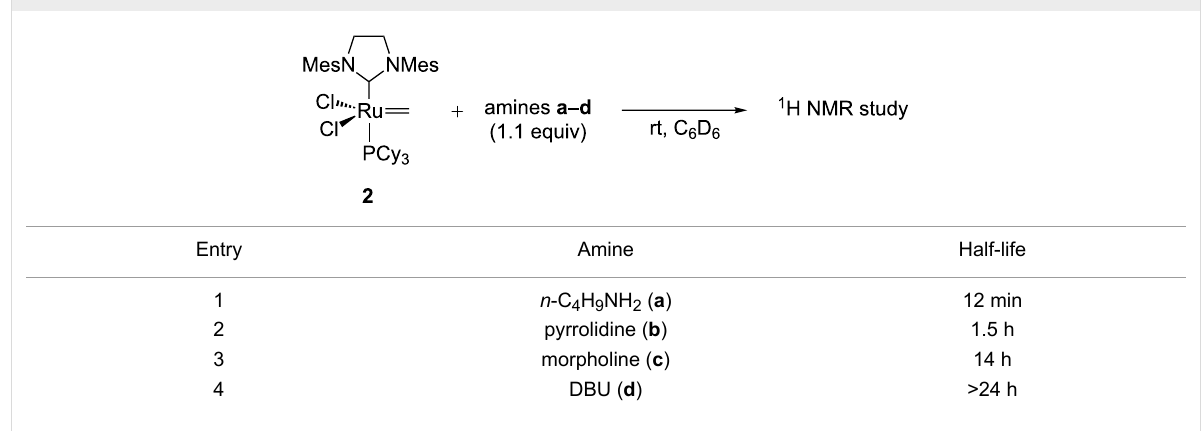
Table 1: Decomposition of methylidene 2 in the presence of amines a – d .